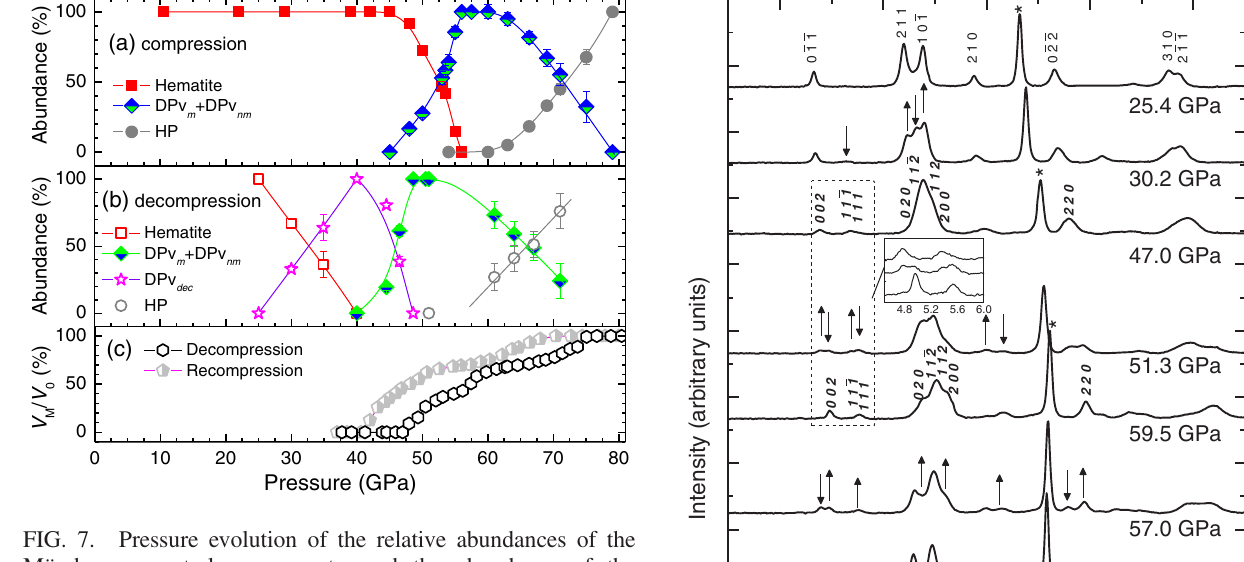
FIG. 7. Pressure evolution of the relative abundances of the Mössbauer spectral components, and the abundance of the metallic phase. The abundances of the Mössbauer spectral components are shown for compression (a) and decompression (b) as computed from the relative areas of the absorption bands. Note the onset of the new DPv component upon decompres- dec sion below 47 GPa, with significant hysteresis in the reappear- ance of the DPv and hematite components. Upon recompression from 25 GPa (not shown), the double-perovskite nonmagnetic (DPv nm ) and doube-perovskite magnetic (DPv m ) components appear again at 50 GPa, with a relative abundance in agreement with the compression trend. The volumetric abundance of the metallic phase is shown for decompression and recompression FIG. 8. X-ray powder diffraction patterns of Fe 2 O 3 at T ¼ (from 37 GPa) (c), as derived from the room-temperature 298 K at various pressures. The double-perovskite (DPv) inter- measurements of electrical resistance (see Supplemental Material mediate-pressure phase, which first appears at approximately [46]). Note the two distinct steps in the V M =V 0 ð P Þ dependence. 53 GPa, is clearly seen at 55.2 GPa. Up- and down-facing arrows Solid curves are guides for the eye. represent an increase and decrease in the DPv and hematite phases, respectively. Upon decompression, the distinctive dou- bling of the diffraction peaks of the DPv phase is observed at about 51 GPa, especially (002), (111), and ( 111 ). A part of the spectrum in the 2 θ range of 4.5° – 6.0° is expanded in the inset to emphasize this doubling. With further decompression below ¯3 c 35 GPa, the peaks of the hematite R structure appear, and, at 25 GPa, the transition to the original hematite phase is complete. The main diffraction peak of the Ne pressure medium is marked with an asterisk. Italics correspond to the diffraction peaks of the DPv